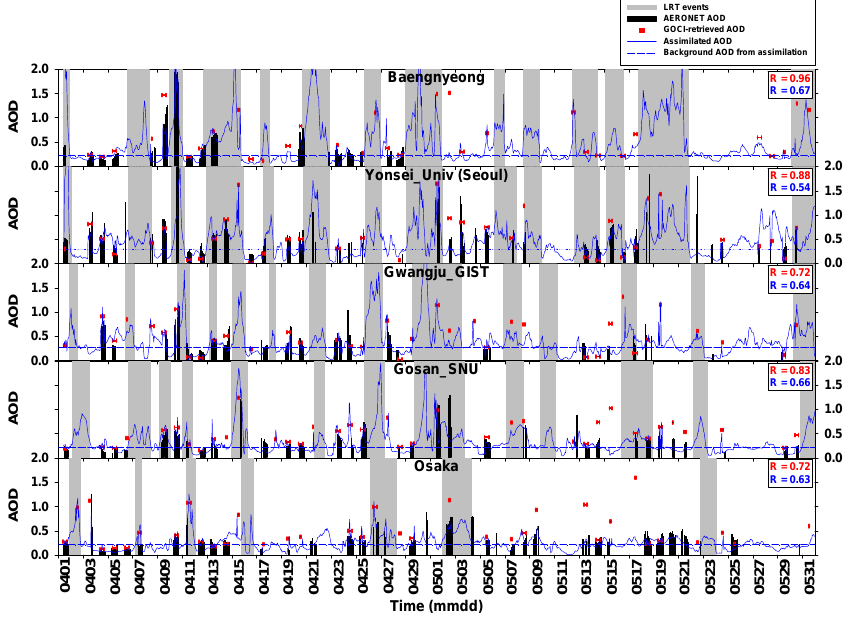
Fig. 7. Time series analysis of AERONET AOD (black bars) and two AOD products (red horizontal bars indicate the GOCI-retrieved AOD products; blue lines represent the assimilated AOD products) over the modeling period of 1 April to 31 May 2011 at five AERONET sites: Baengnyeong, Yonsei_Univ (Seoul), Gwangju_GIST, Gosan_SNU, and Osaka. The averaged background AODs estimated from the assimilated AOD values during non-LRT events are presented by blue dashed lines. Also, the periods of LRT events are displayed with grey-shaded areas.